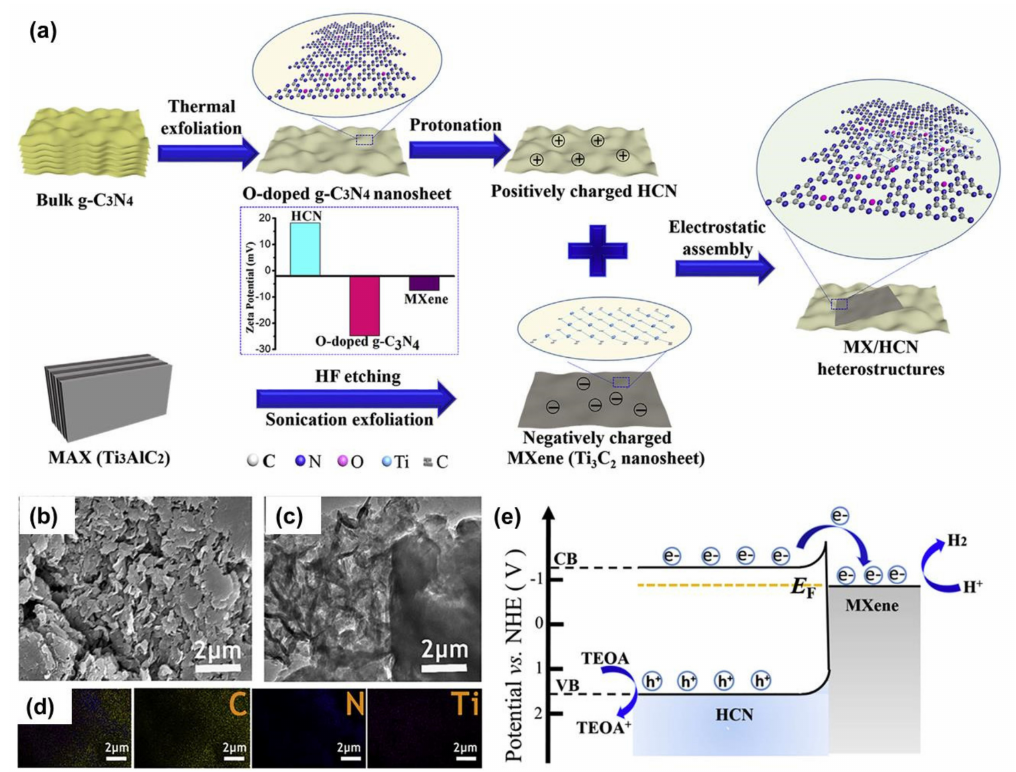
Figure 8. ( a ) Fabrication process of the Ti 3 C 2 T x / O-doped g –C 3 N 4 heterostructure. ( b – d ) SEM images, TEM images, and EDS spectra of Ti 3 C 2 T x / O-doped g –C 3 N 4 . ( e ) The working mechanism of Ti 3 C 2 T x / O-doped g –C 3 N 4 photocatalyst. Reproduced with permission from reference [87].